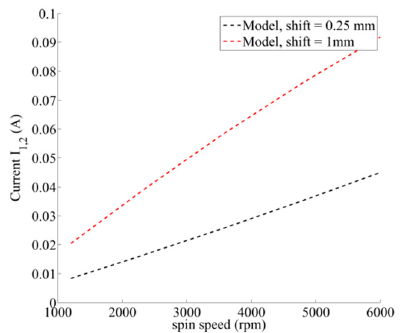
Figure 26. Predicted current in the second coil of the first phase for center shifts of 0.25 and 1 mm in the case of the electrodynamic bearing prototype with motor terminals with resistive load of 200 Ω and one additional inductor on each coil.